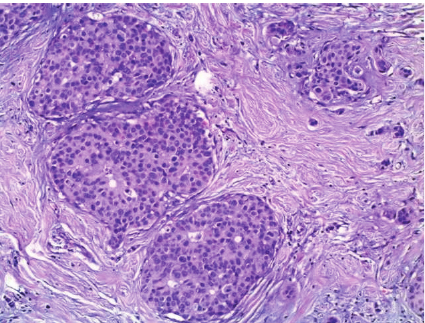
Figure 5: Primary tumor in breast, in situ component of the tumor with solid and cribriform pattern, X & @ , ×